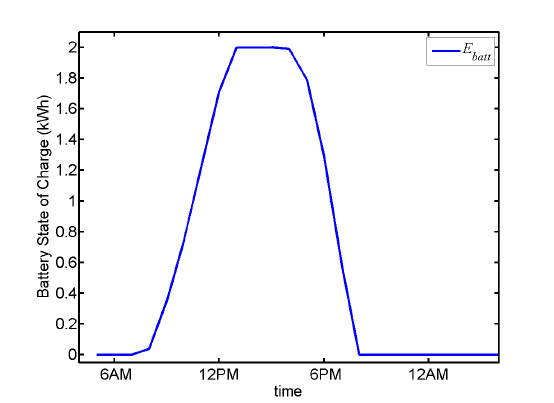
Figure 12. State of charge (kWh) of the battery with an upper limit of 2 kWh.